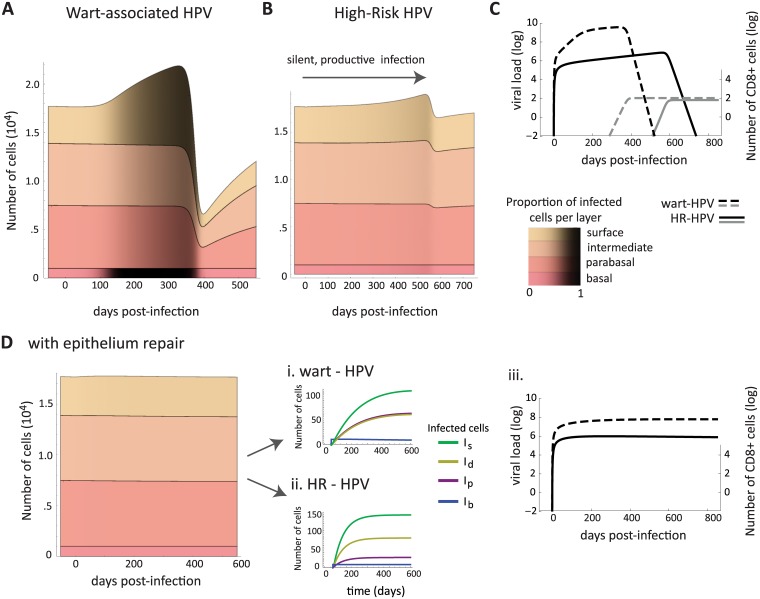
Simulated population dynamics of epithelial cells, immune effectors and free viruses in the case of HPV infections.Wart-like epithelial dynamics in a wart-associated HPV infection (A) and a slow growing high-risk (HR) HPV infection that spontaneously regresses (B). The black shading shows the proportion of infected cells in each layer. (C) Dynamics of virus load (black) and the density of immune effectors (gray) for wart-associated HPV (dashed line) and HR-HPV (full line) infections. Immune cells start to proliferate upon infection but their number remains below −2 log for several months. (D) Simulated scenario where the infection is inoculated with few cells and the microabrasion repairs quickly: this results in both wart-associated and HR types causing asymptomatic infections. Here, the model predicts that infections with HR types have more infected cells, due to their higher proliferative properties, but wart-associated types produce more virions (i, ii, iii), and both infections can last for years, if stochasticity or the innate response do not clear them (i, ii). Parameter values are default (Tables 1 and 3) and infection models are 3. Infection rates of both wart-associated and HR HPVs are identical (β = 10−10) and all infections begin with 10 infected basal cells. In (D) the infection rate, β, decays to zero in 10 days (b = −0.5) to mimic tissue repair (see section A.3 in S1 Text for details).